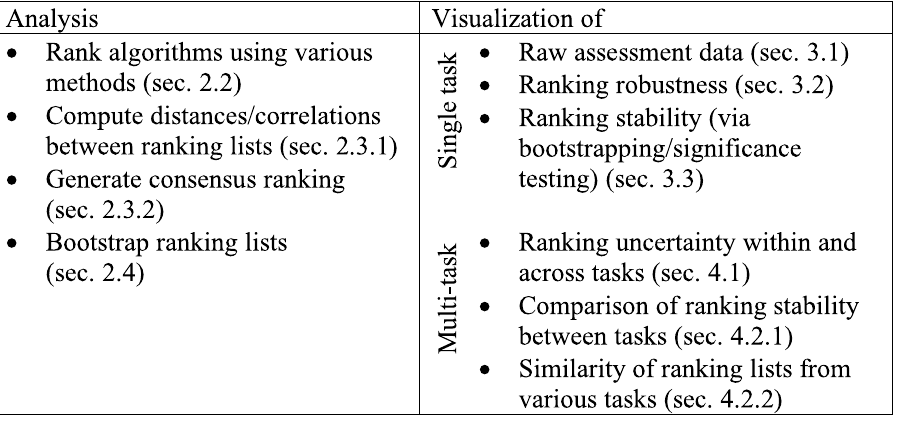
Figure 9. challengeR as a toolkit for challenge analysis and visualization: summary of